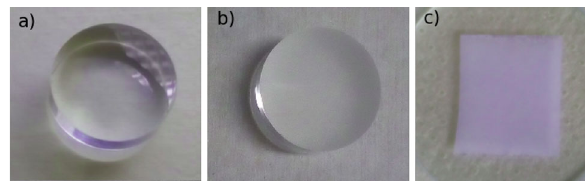
Fig. 4 a RPT acrylic sample before sanding. b RPT acrylic sample after sanding. c TPB reference sample